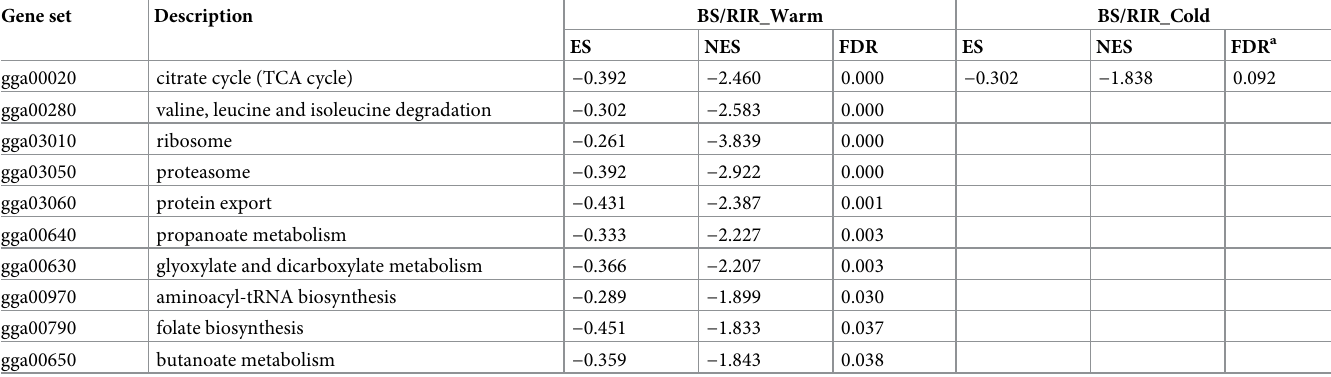
Table 6. GSEA tests for KEGG pathway enrichments for BS/RIR under cold and warm environments. Gene